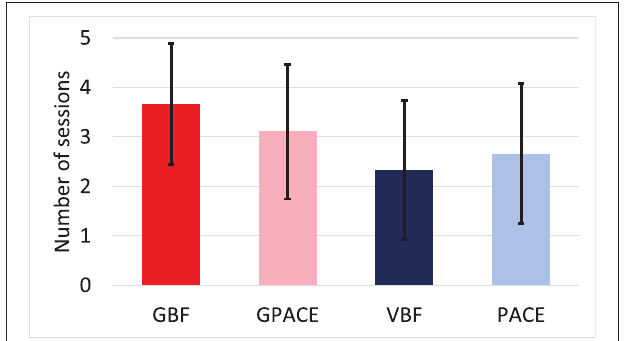
FIGURE 8 | Average number of times the treatment intervention was used during the treatment